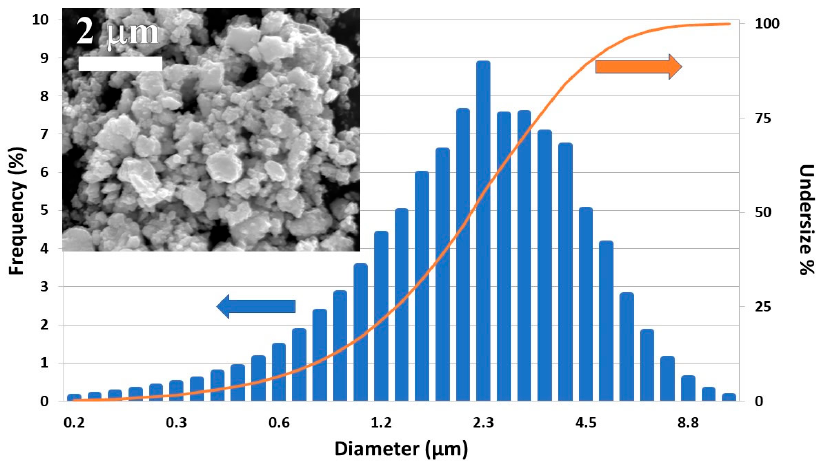
Figure 3. Particle size distribution (PSD) analysis of SM ZnSb milled for 10 min at 250 rpm with a planetary ball mill. Inset shows SEM secondary image of the powder.